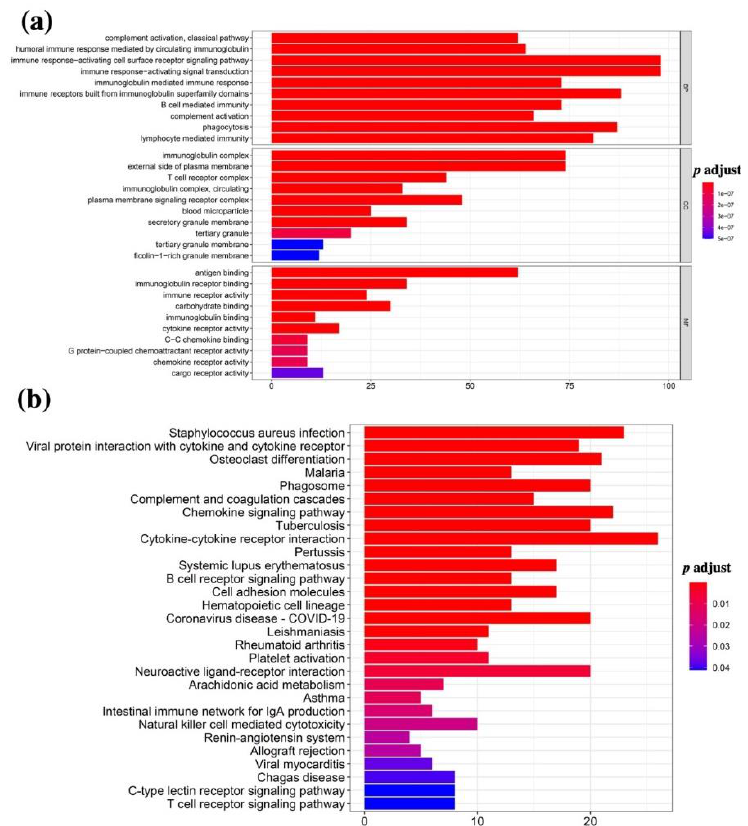
Figure 4. Gene enrichment analysis of the DEGs based on the immune and stromal scores in OSCC patients. ( a ) Gene ontology (GO) enrichment analysis of DEGs based on the immune and stromal scores in OSCC patients. Top panel is the biological process analysis of GO enrichment. Middle panel is the cellular component analysis of GO enrichment. Bottom panel is the molecular function analysis of GO enrichment. ( b ) Kyoto Encyclopedia of Genes and Genomes (KEGG) pathway analysis of DEGs based on the immune and stromal scores in OSCC